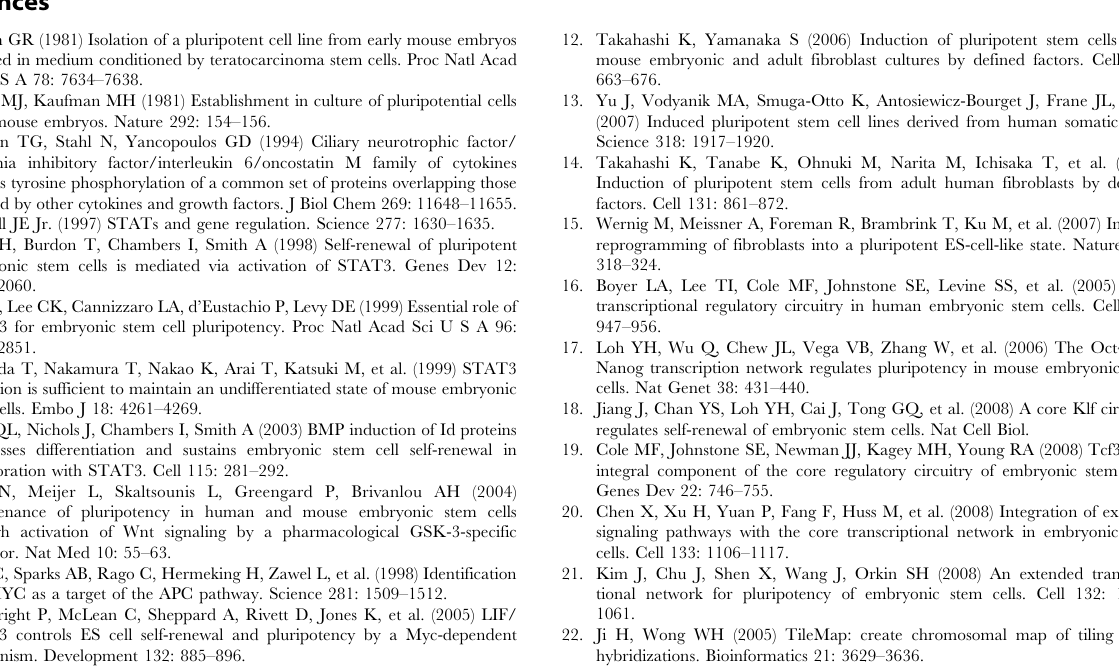
Table S1 Stat3 bound regions in murine ES cells